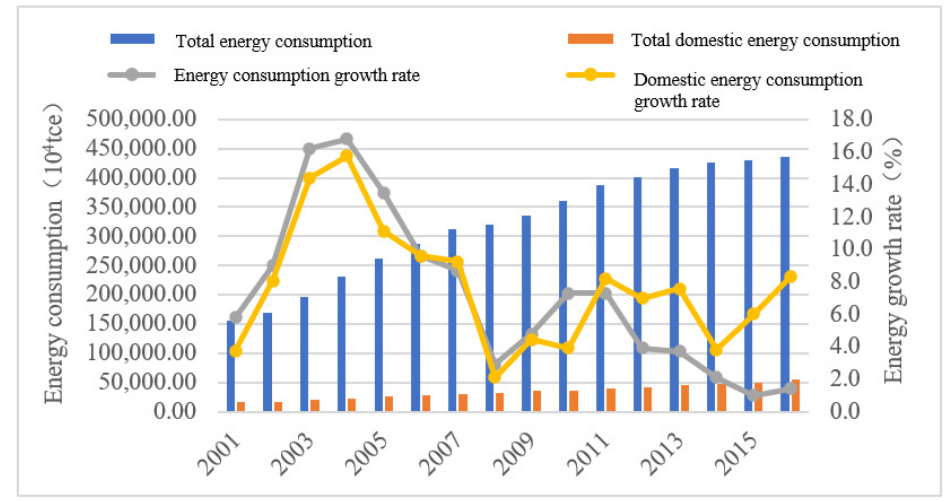
Figure 1. 2001–2015 total energy/domestic energy consumption and its growth rate in China. Source: China Energy Statistics Yearbook (2002–2017)